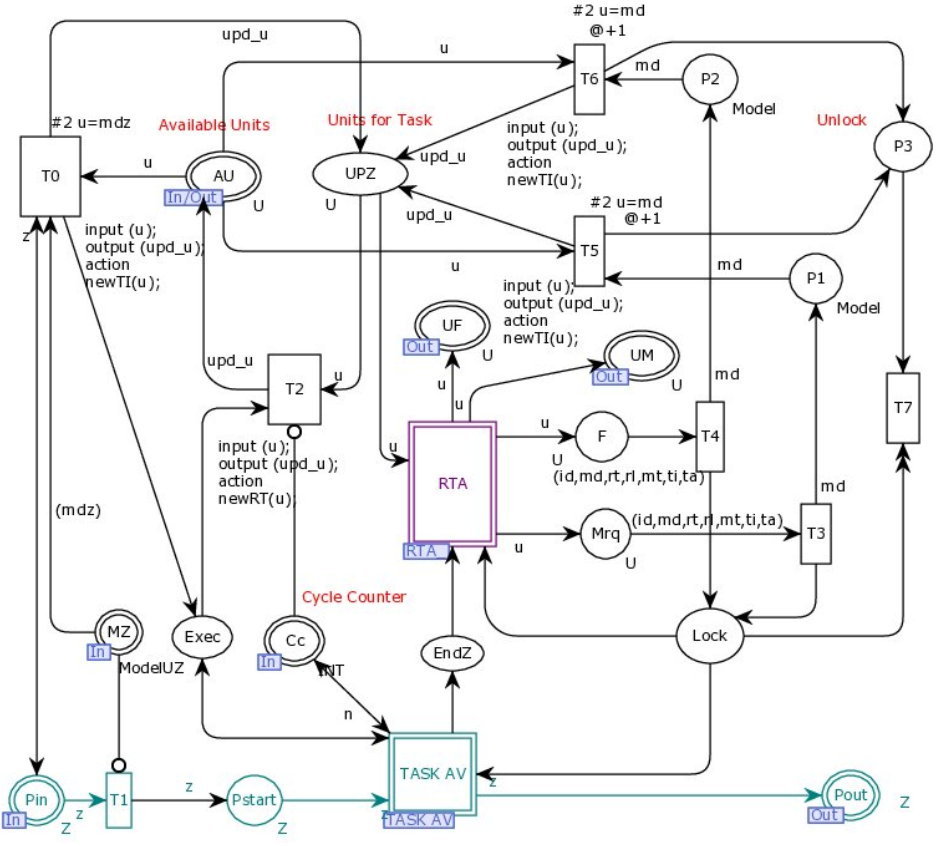
Figure 5. Structure of the ZExec module.